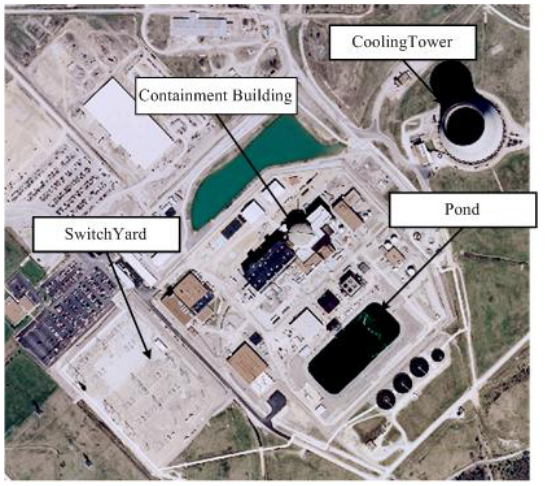
Figure 2. Workflow formulation – a crisp